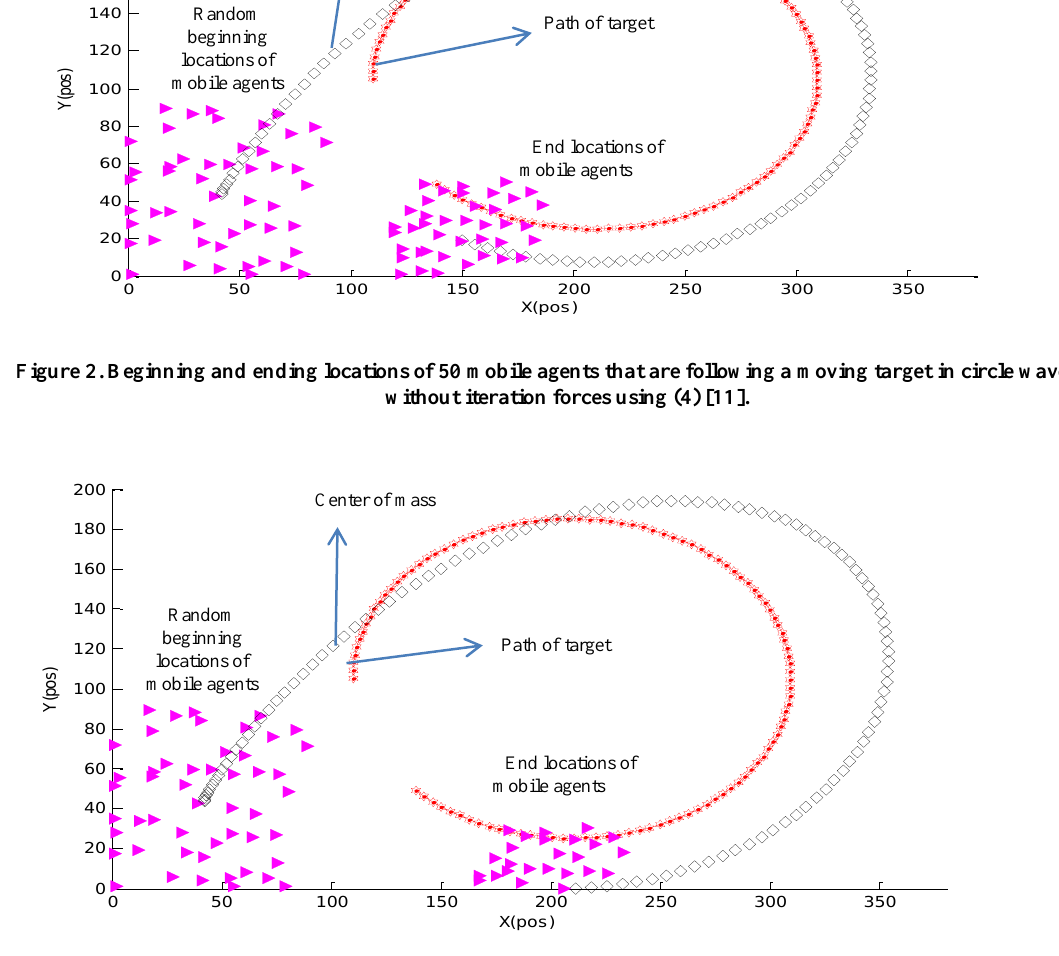
Figure 3. Beginning and ending locations of 50 mobile agents that are following a moving target in circle wave path with extended flocking control algorithm using (9)